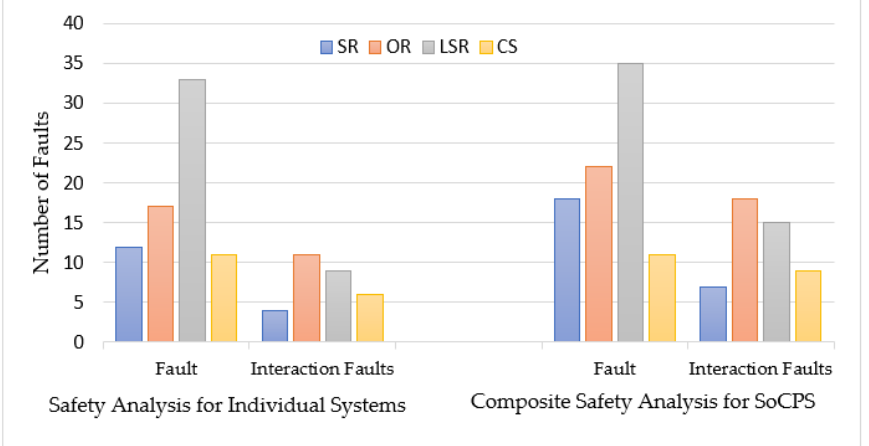
Figure 8. Comparision between traditional safety analysis and composite safety analysis for HRRS.